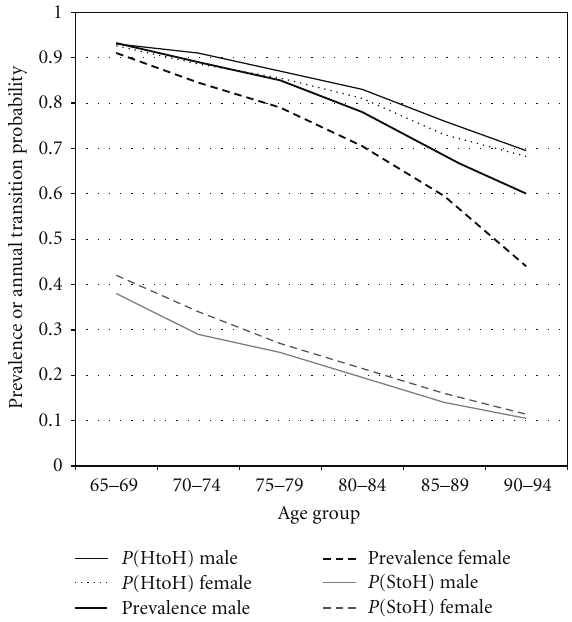
Figure 2: Prevalence, maintenance, and recovery for ADL Health by age and sex. The prevalence estimates are the proportion with no ADL di ffi culties. The transition probability estimates are the likelihoods of remaining healthy (P(HtoH)) and of returning to health (P(HtoS)) over one-year